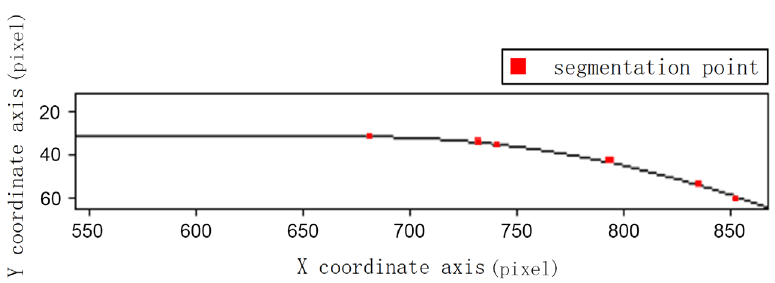
Figure 12. Segmentation points detected at large arc tangents by adaptive steps.